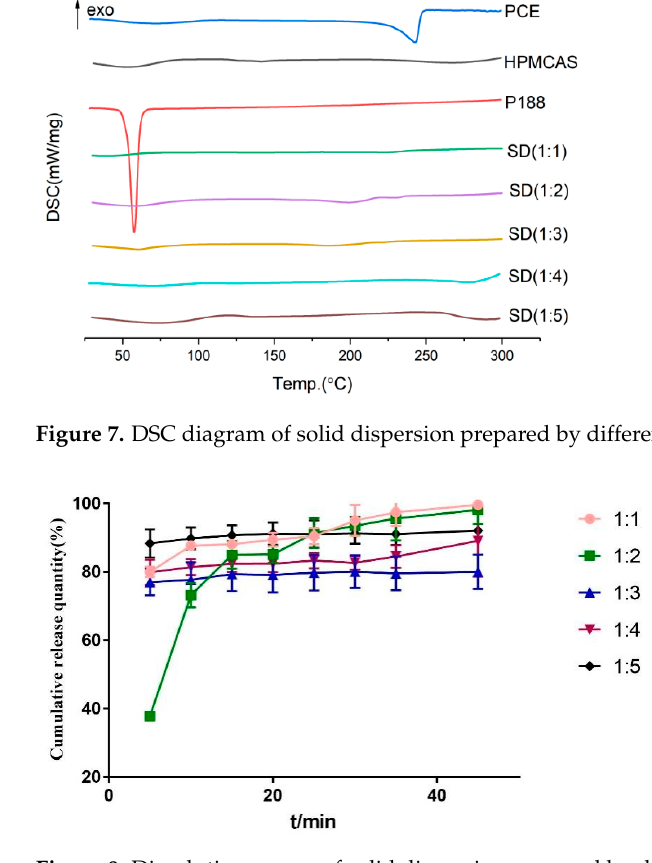
Figure 8. Dissolution curves of solid dispersion prepared by different mass ratio.